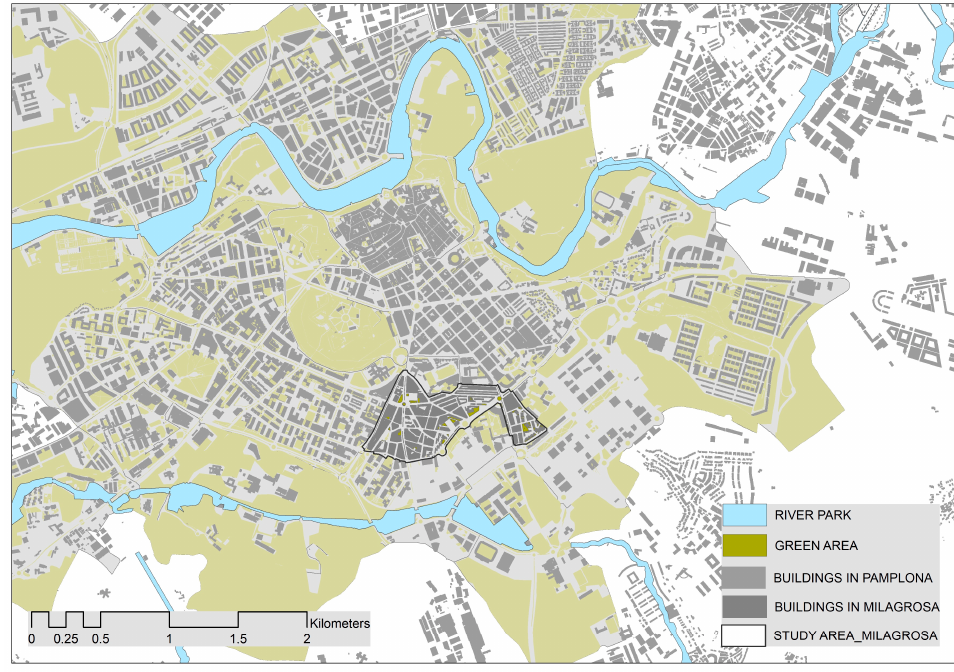
Figure 2. Location of the study area, in the neighbourhood of La Milagrosa in the city of Pam- plona. It was built “urgently” on the basis of a spatial and volumetric arrangement that was marked by the new airs that the Modern Movement began, in which building architecture is the exclusive protagonist and the rationalist residential block dominates. Building was the priority; towers and detached blocks were arranged according to orography, sunlight and access [51] or, inevitably, road space, and, in addition, connections between the dif- ferent areas of partial development were missing, leaving interstitial spaces without in- tention or purpose [50].